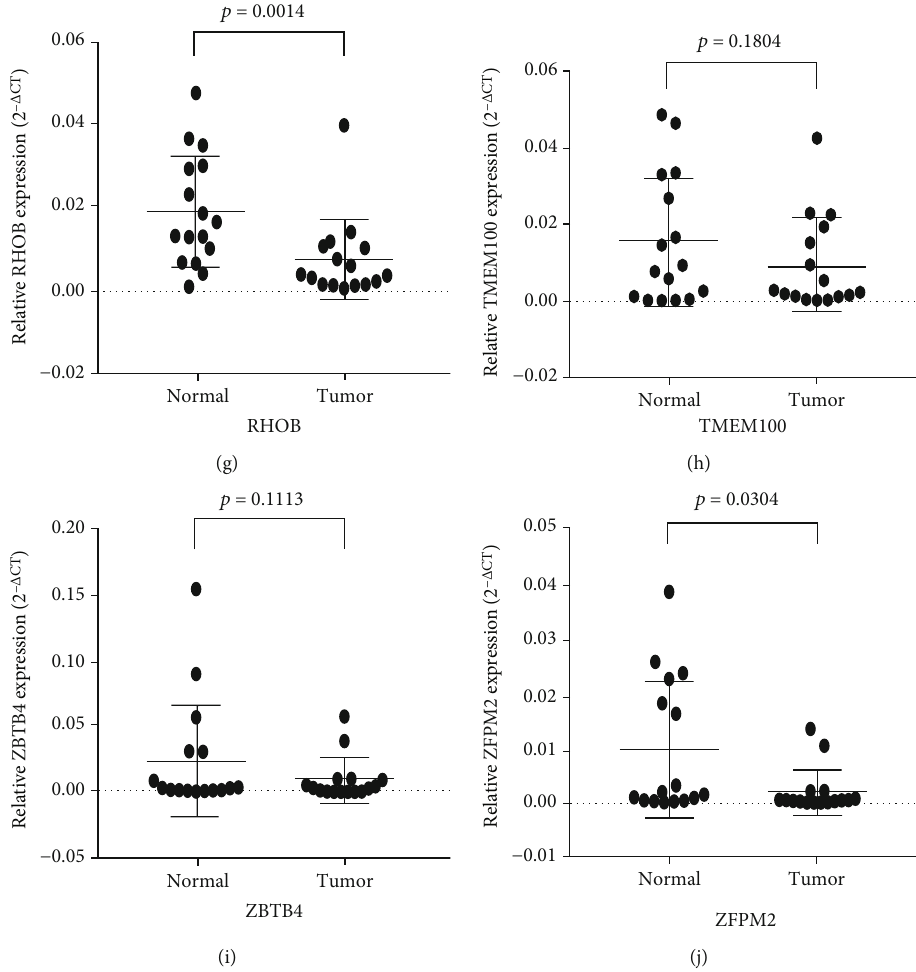
Figure 8: Expression validation of the top 10 hub mRNAs in 16 patients by qRT-PCR. The signi fi cant di ff erence was under the condition of P value < 0.05.